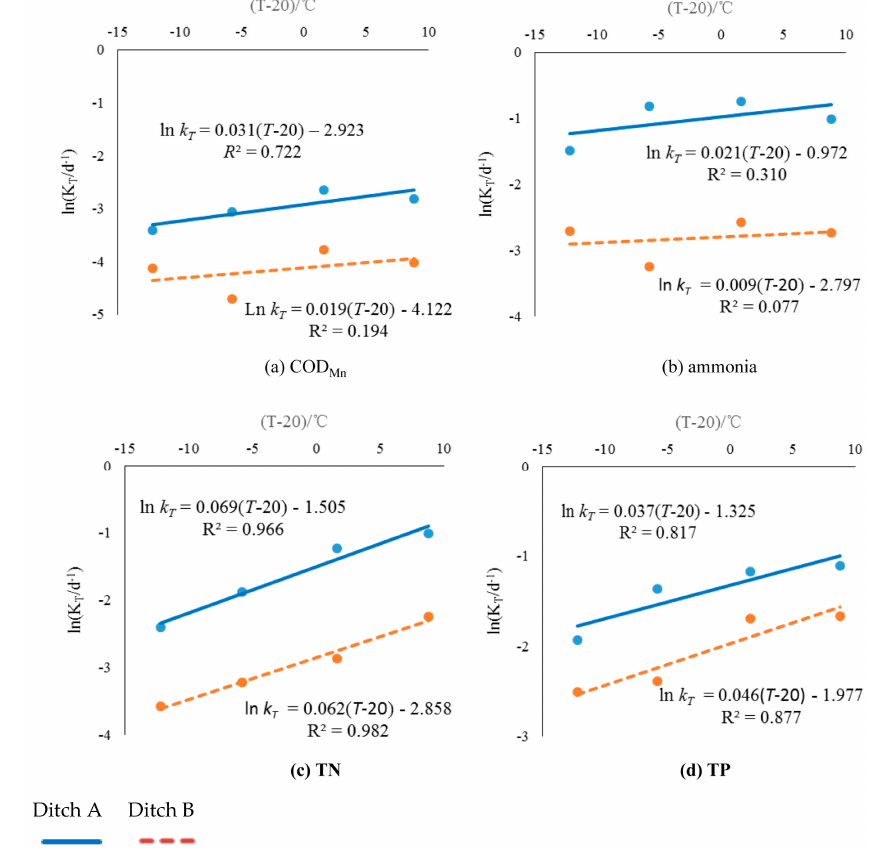
Figure 3. The relationship between k and temperature. Table 4. Values of k 20 and θ obtained from the Arrhenius